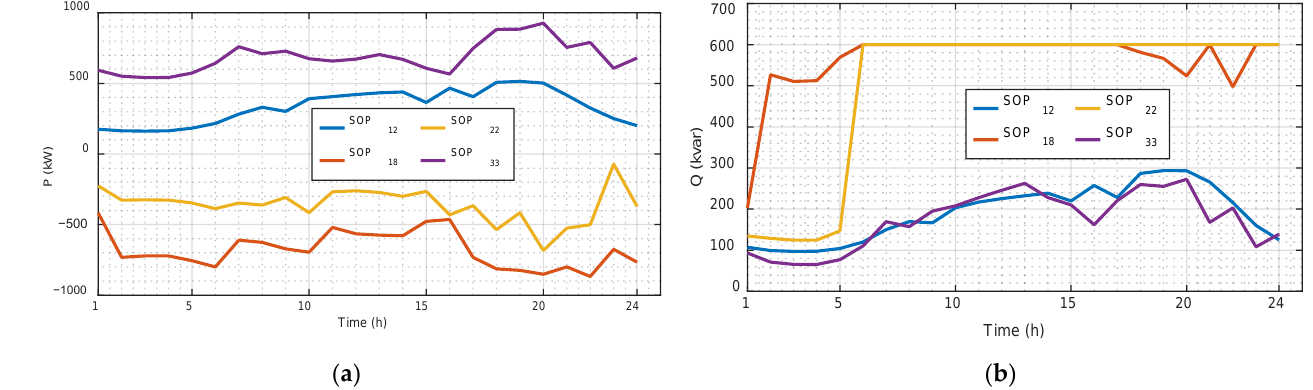
Figure 12. DC -microgrids scheduling for: ( a ) MG 1; and ( b ) MG 2.